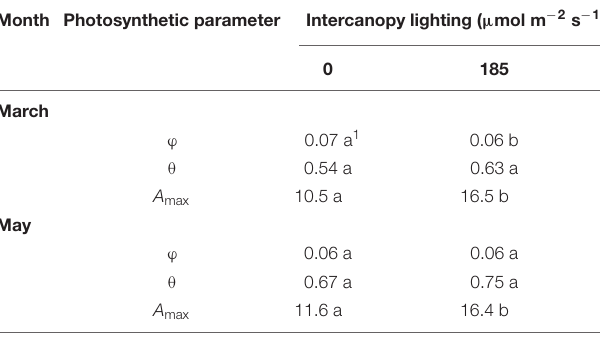
TABLE 2 | Blackberry fresh fruit harvest for 0, 93, or 185 µ mol m − 2 s − 1 ICL. Fruit yield parameter (per cane)